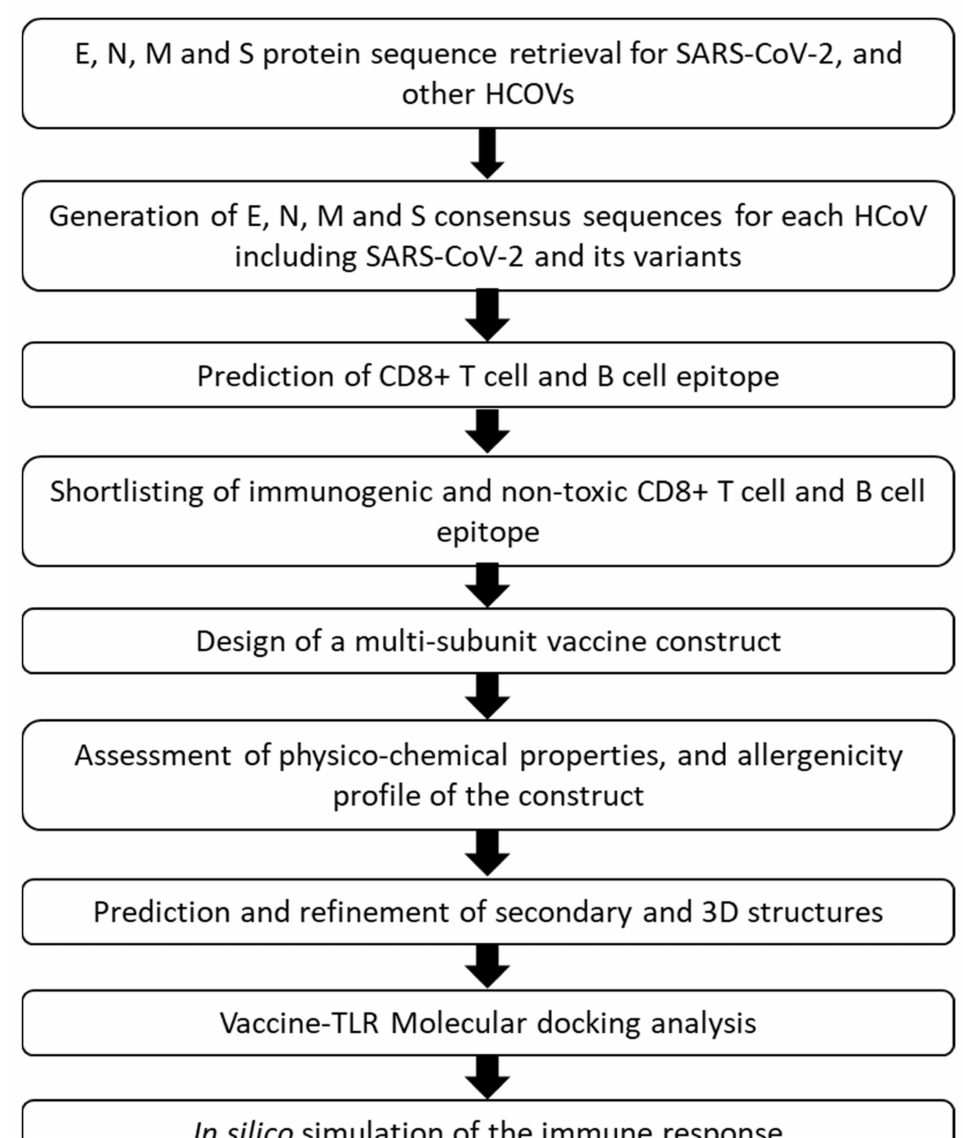
Figure 1. Vaccine design